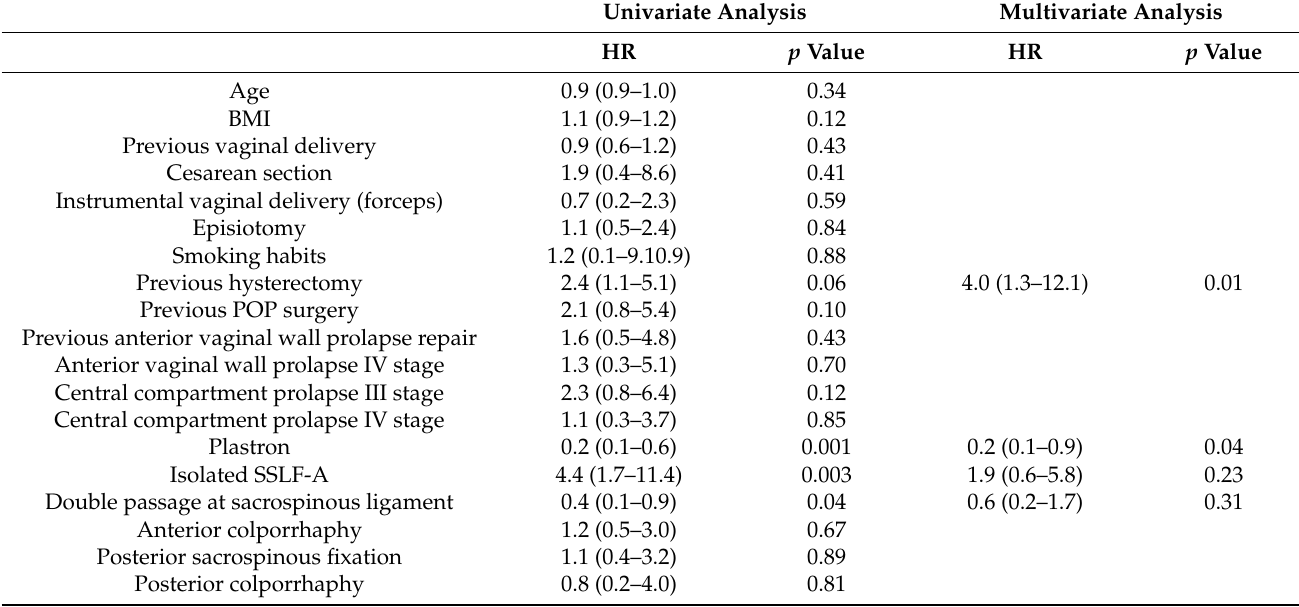
Table 8. Risk factors for surgical failure and anterior vaginal wall prolapse relapse. Univariate Analysis Multivariate